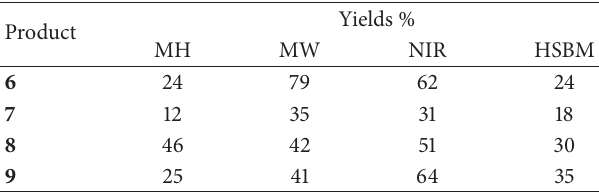
Table 1: Production of indolylquinones derivatives, using different activating modes.